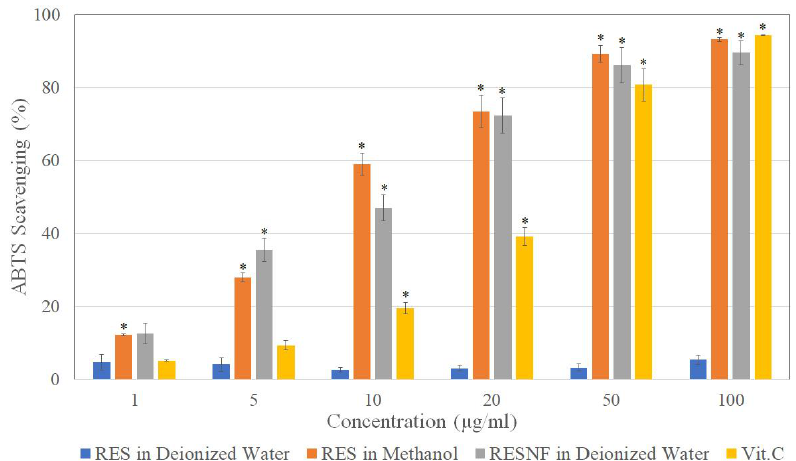
Figure 7. ABTS free radical scavenging activity of resveratrol in deionized water, resveratrol in methanol, resveratrol nanofibers (RESNF) in deionized water, and vitamin C at various concentrations. Results are shown as mean ± SEM of three independent experiments. * represents P < 0.05 when compared to resveratrol in deionized